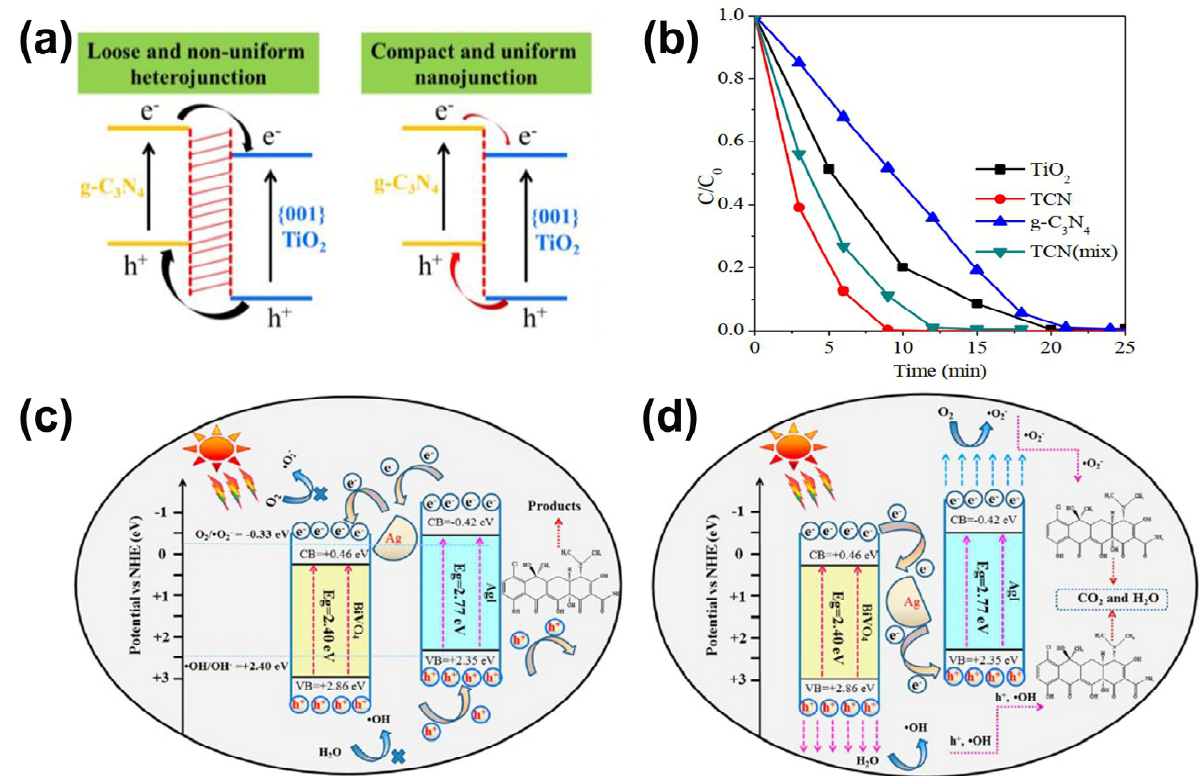
Figure 8. ( a ) Proposed heterojunction differences between TCN and TCN(mix) ( b ) Photocatalytic degradation efficiencies of tetracycline by employing TiO 2 , TCN, TCN (mix), and g-C 3 N 4 as the photocatalysts under the xenon lamp irradiation. (Reproduced with permission from [87], copyright 2017, Elsevier). Schematic Illustration of the Mechanism for the Photocatalytic Degradation of tetracycline under Visible Light Irradiation over AgI/BiVO 4 Nanocomposite: ( c ) Traditional Model and ( d ) Z-Scheme Heterojunction System. (Reproduced with permission from [88], copyright 2016, American Chemical Society).